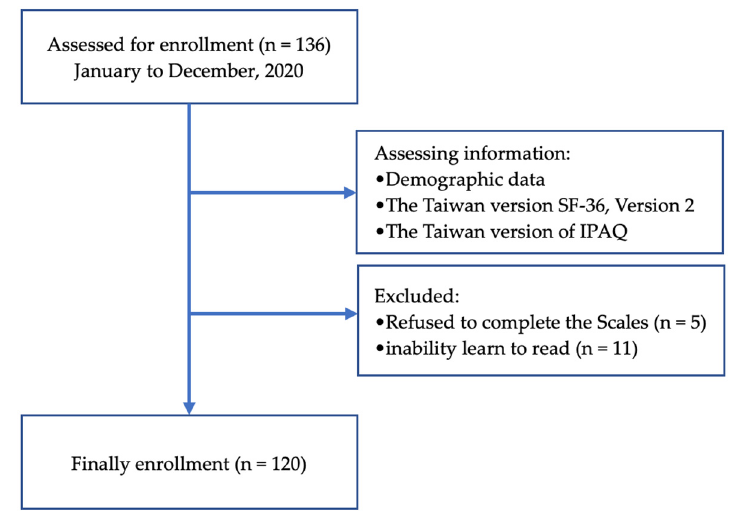
Figure 1. Flowchart for the present cross-sectional study.